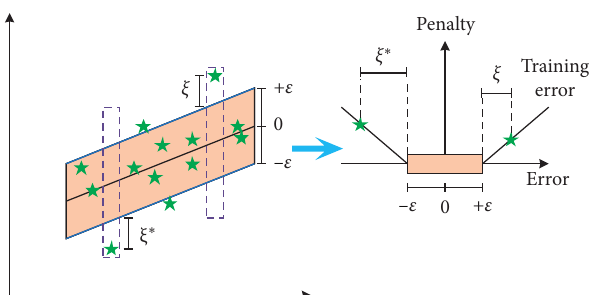
Figure 3: Schematic view of a linear SVR technique, ε -insensitive loss function, and slack